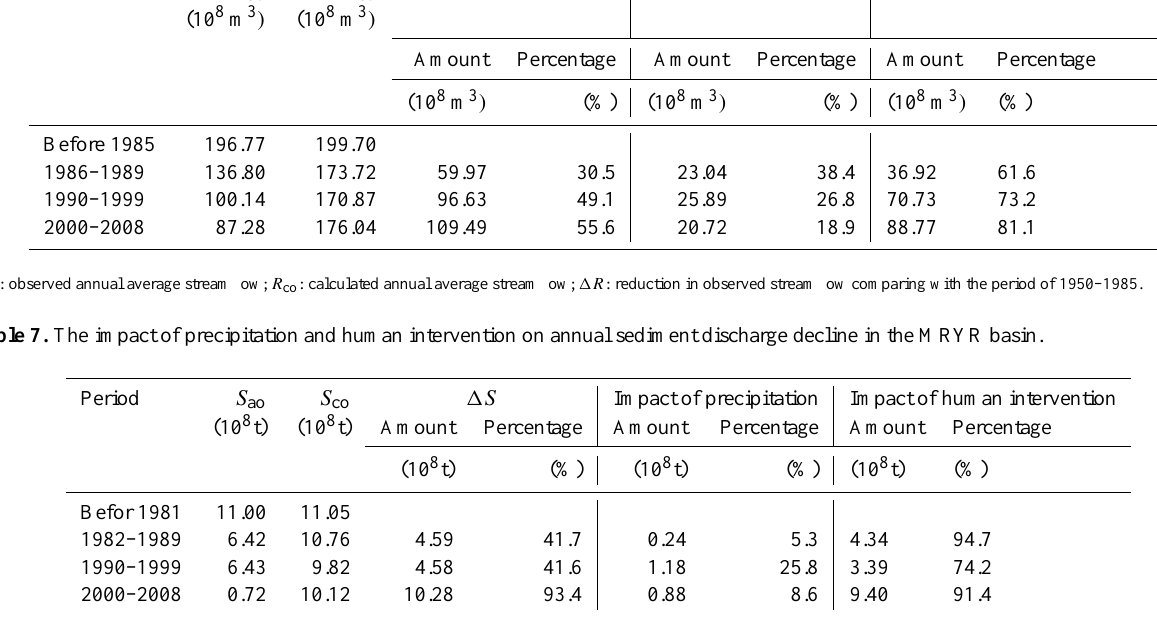
Table 6. The impact of precipitation and human intervention on annual streamflow decline in the MRYR basin. Period R ao R co 1R Impact of precipitation Impact of human intervention (10 8 m 3 ) (10 8 m 3 ) Amount Percentage Amount Percentage Amount Percentage (10 8 m 3 ) (%) (10 8 m 3 ) (%) (10 8 m 3 ) (%) Before 1985 196.77 199.70